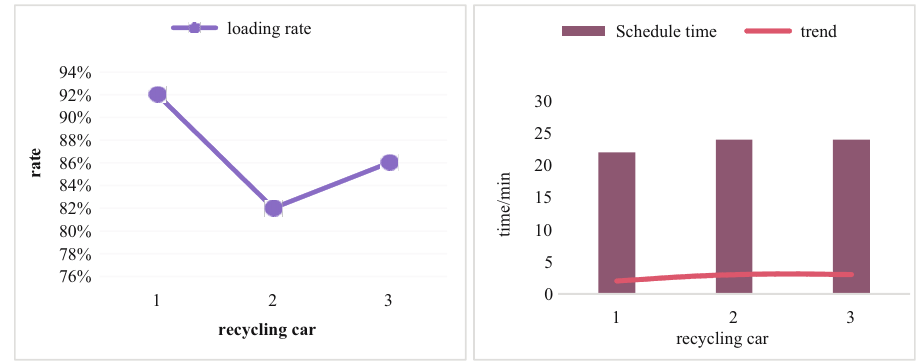
Figure 7: Recycling vehicle loading rate and travel time data: ( a ) loading rate and ( b ) travel